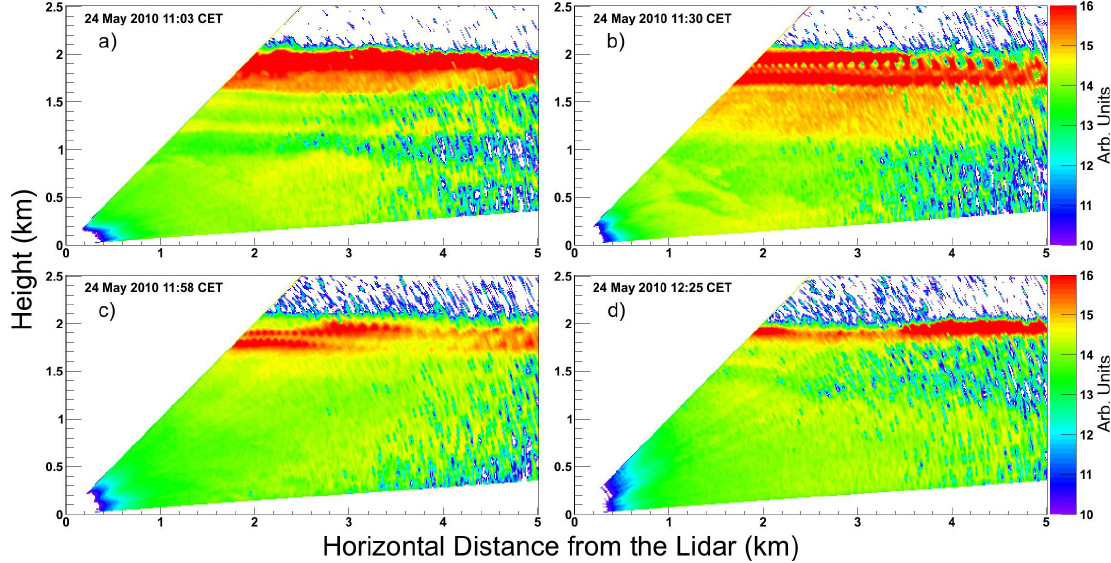
Fig. 3. Time series of vertical RHI scans showing the logarithm of the range-corrected LIDAR signal for elevation angles from 4 ◦ to 45 ◦ with angular step of 1 ◦ . The scans were performed between 11:00 and 12:30CET on 24 May 2010. The presence of a lower layer of clouds can be seen throughout the scanning period at the altitude of 2km, relative to the LIDAR site. Above 2km, LIDAR signal is effectively blocked by the clouds.